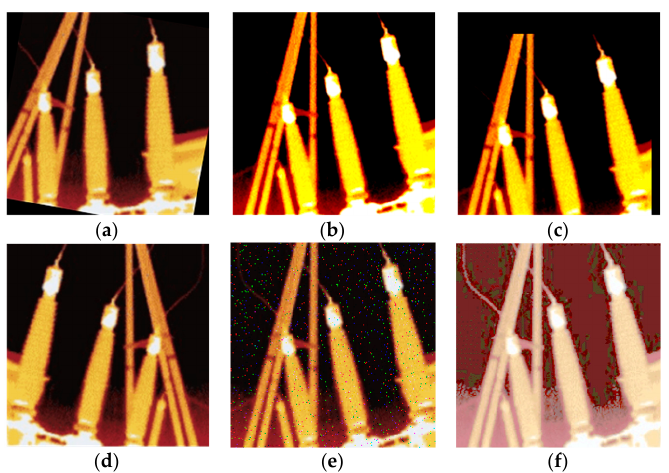
Figure 6. Schematic diagram of data augmentation: ( a ) rotating, ( b ) contrast changing, ( c ) translation, ( d ) mirroring, ( e ) salt and pepper noise, ( f ) histogram equalization.